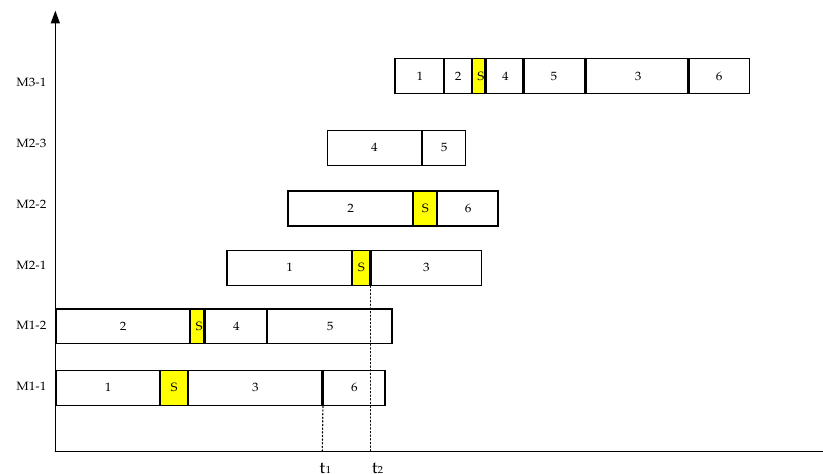
Figure 1. HFSP based on parallel sequential movement pattern.